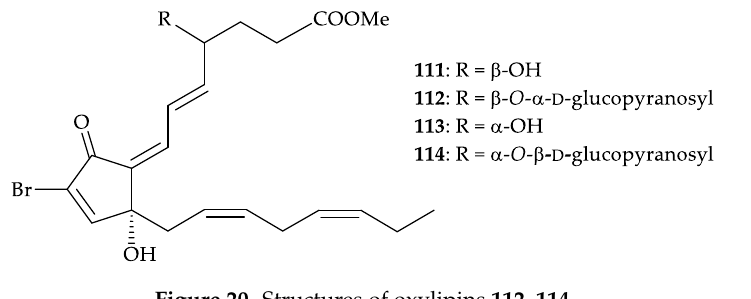
Figure 20. Structures of oxylipins 112 – 114 .